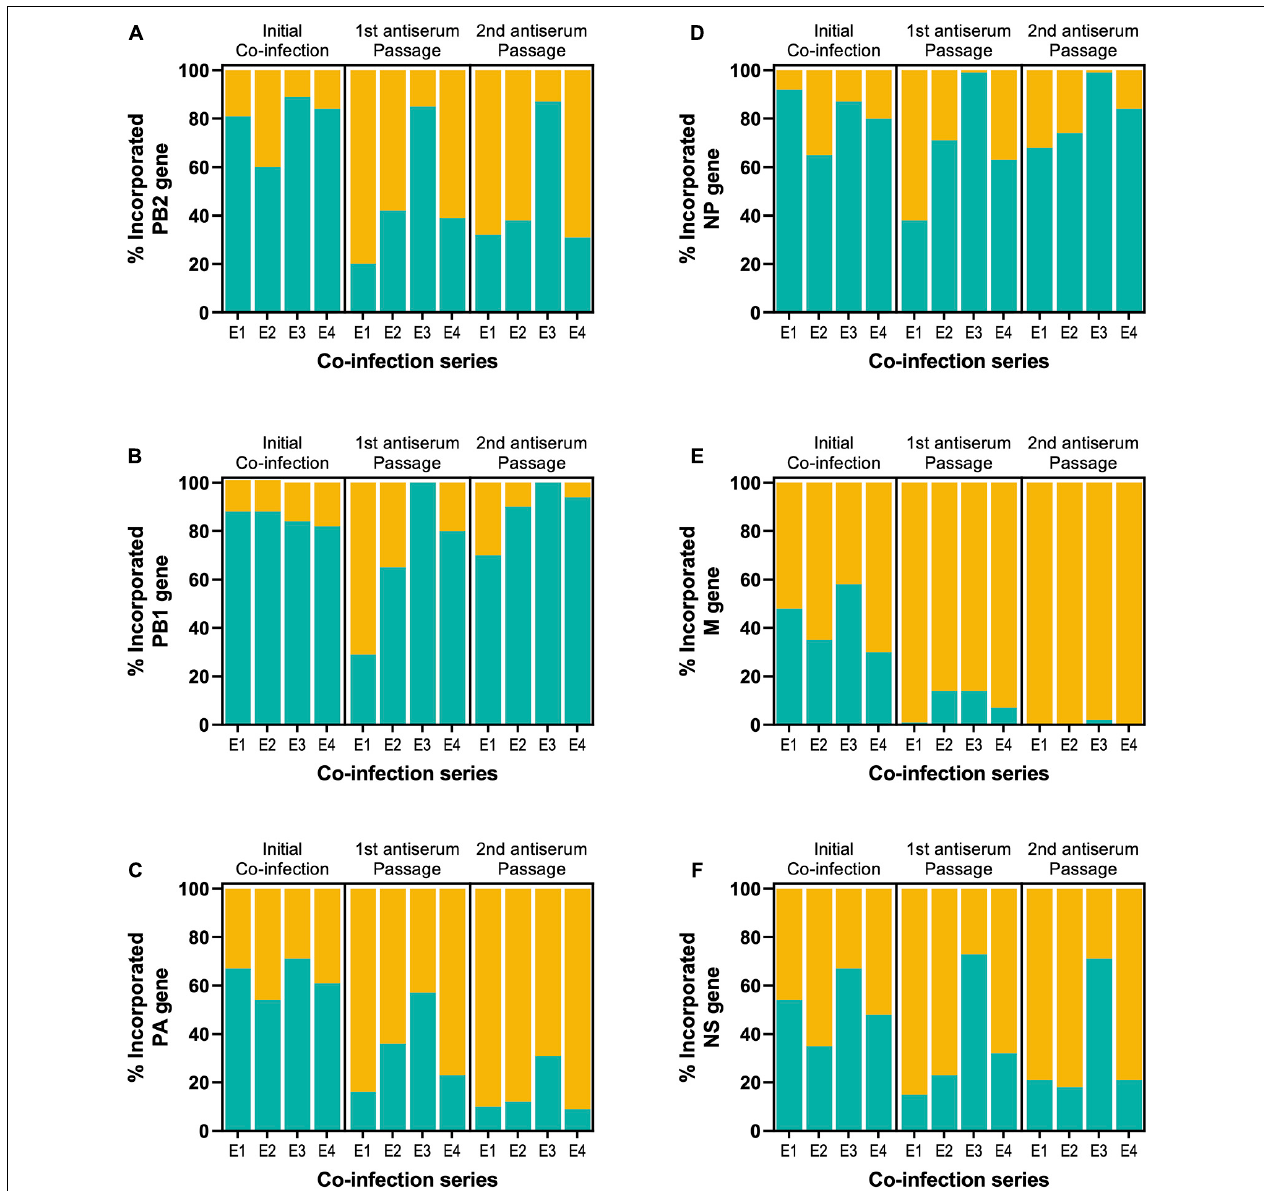
FIGURE 3 | Tracking the frequency of the six internal Udorn (teal) and PR8 (orange) genes throughout the reassortment process. The source of individual genes in the reassortants shown in Figure 2 is summarised for each series. Data are expressed as a percentage of the total viruses isolated in that series at each stage of the reassortment process, with replicate eggs pooled for the first (two eggs) and second (four eggs) antisera passages. The origin of the (A) PB2, (B) PB1, (C) PA, (D) NP, (E) M, and (F) NS genes were determined to be either from the PR8 parent (orange) or the Udorn parent (teal).